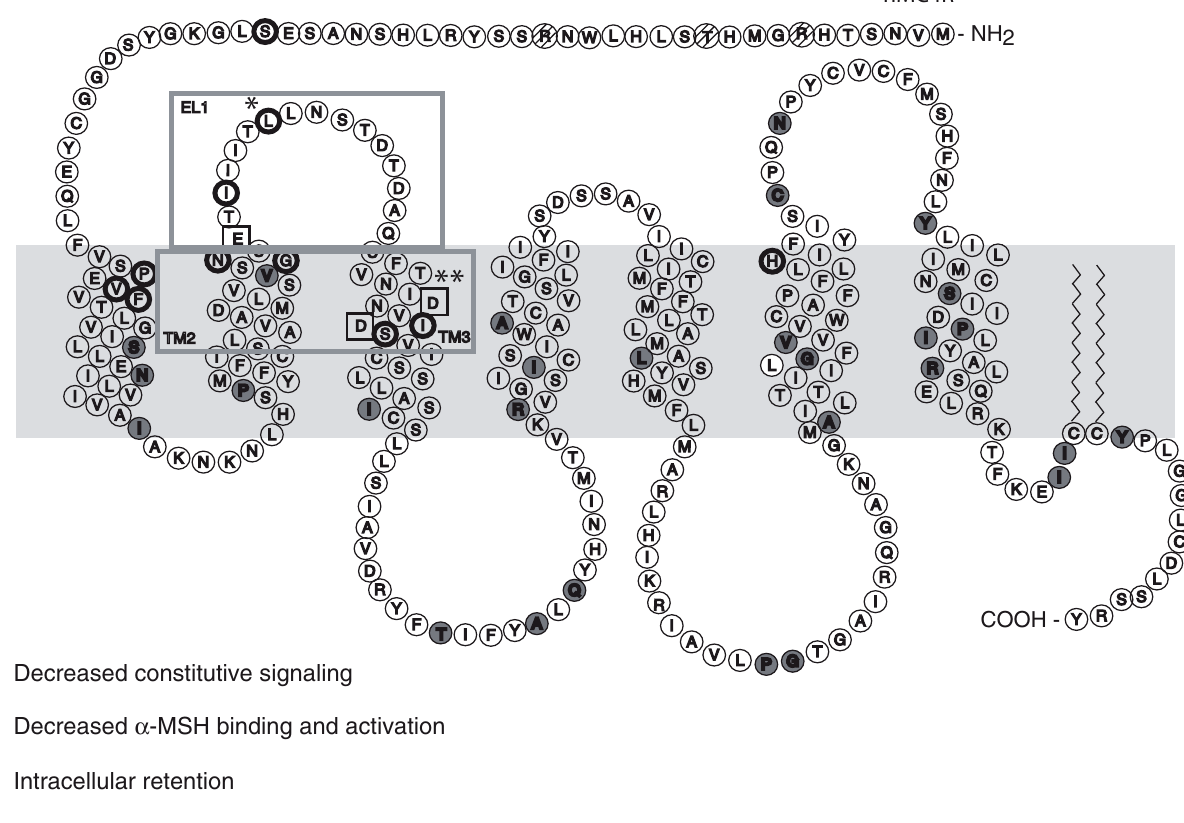
Figure 1. Model of the melanocortin-4 receptor. Boxed region indicates EL1, *L106P (Rm1), **D122A (Rm2).